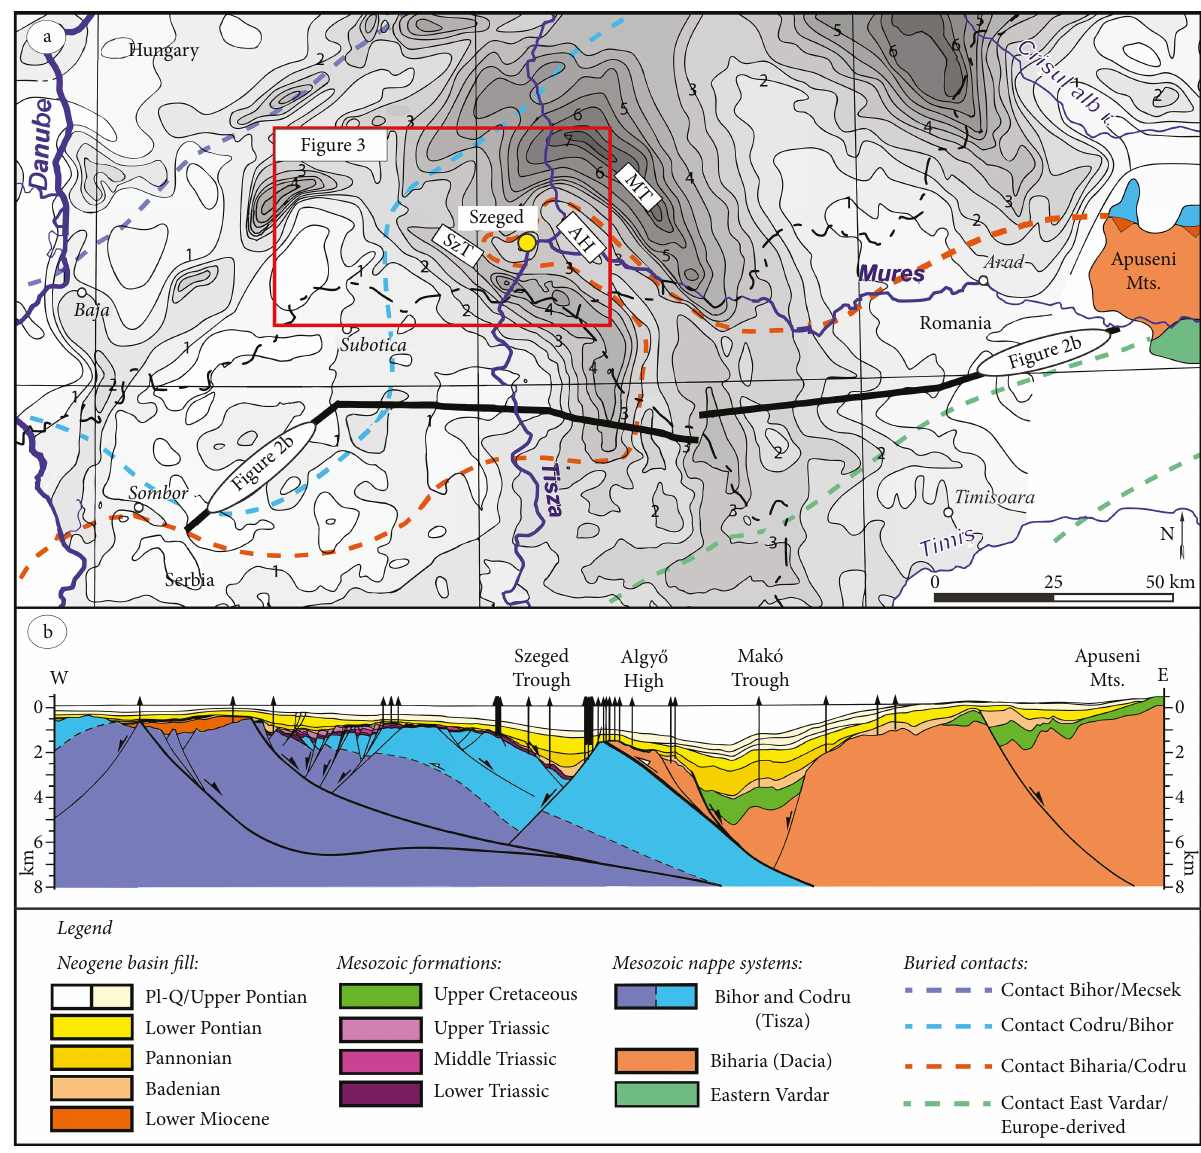
Figure 2: Generalized basement map together with a schematic cross section of the southern Pannonian Basin, showing the stratigraphic and structural relationships [24, 25]. (a) Structural map of the pre-Neogene basement of the Pannonian Basin in SE Hungary and neighboring Serbia and Romania. Isoline numbers are in kilometers. Abbreviations: SzT =Szeged Trough; AH =Algy ő High; MT=Makó Trough. (b) WSW – ENE regional transect over the southern part of the Pannonian Basin (Serbia and Romania). The location of the interpreted seismic sections is displayed in (a). Note: the cross section is 4 times vertically